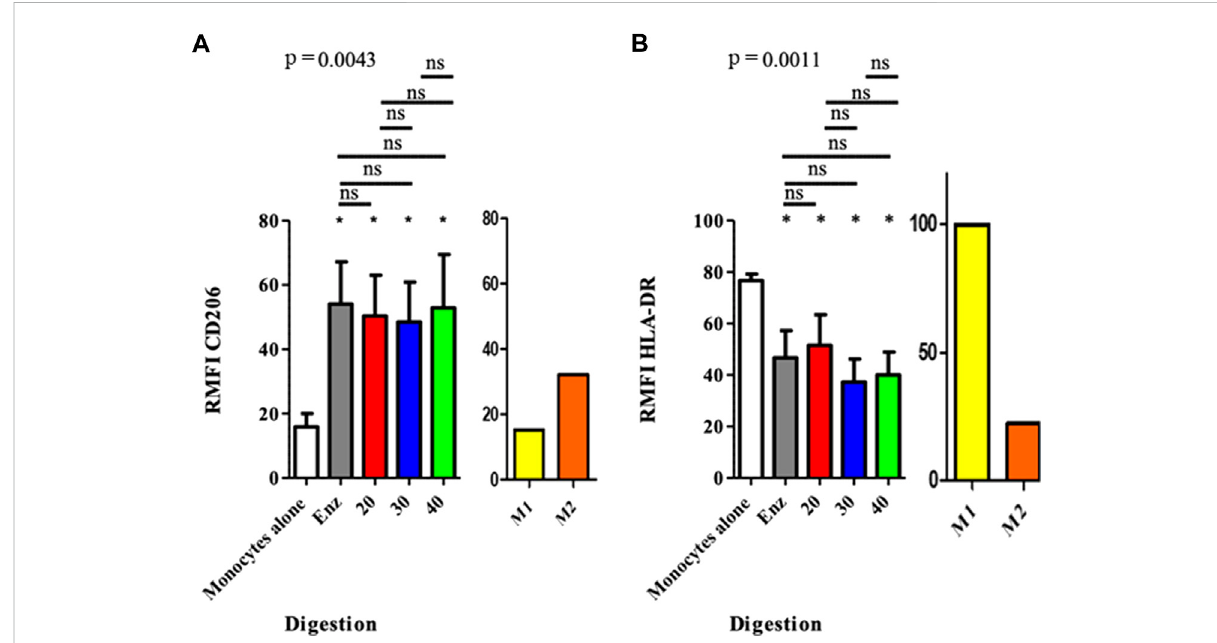
FIGURE 7 Polarization of macrophages after co-culture with ASCs at the end of P0. The results are expressed as the fl uorescence ratio of the TEST tube/ FMOtube,obtained bymonoparametrictest.Iftheratiois < 1,themarkerisnotexpressed;between1and2,theexpressionofthemarkercannotbe concluded, and 2 the marker is expressed. * p < 0.05, ** p < 0.001, and *** p < 0.0001; ns: not signi fi cant. ASCs: adipose-derived mesenchymal stem